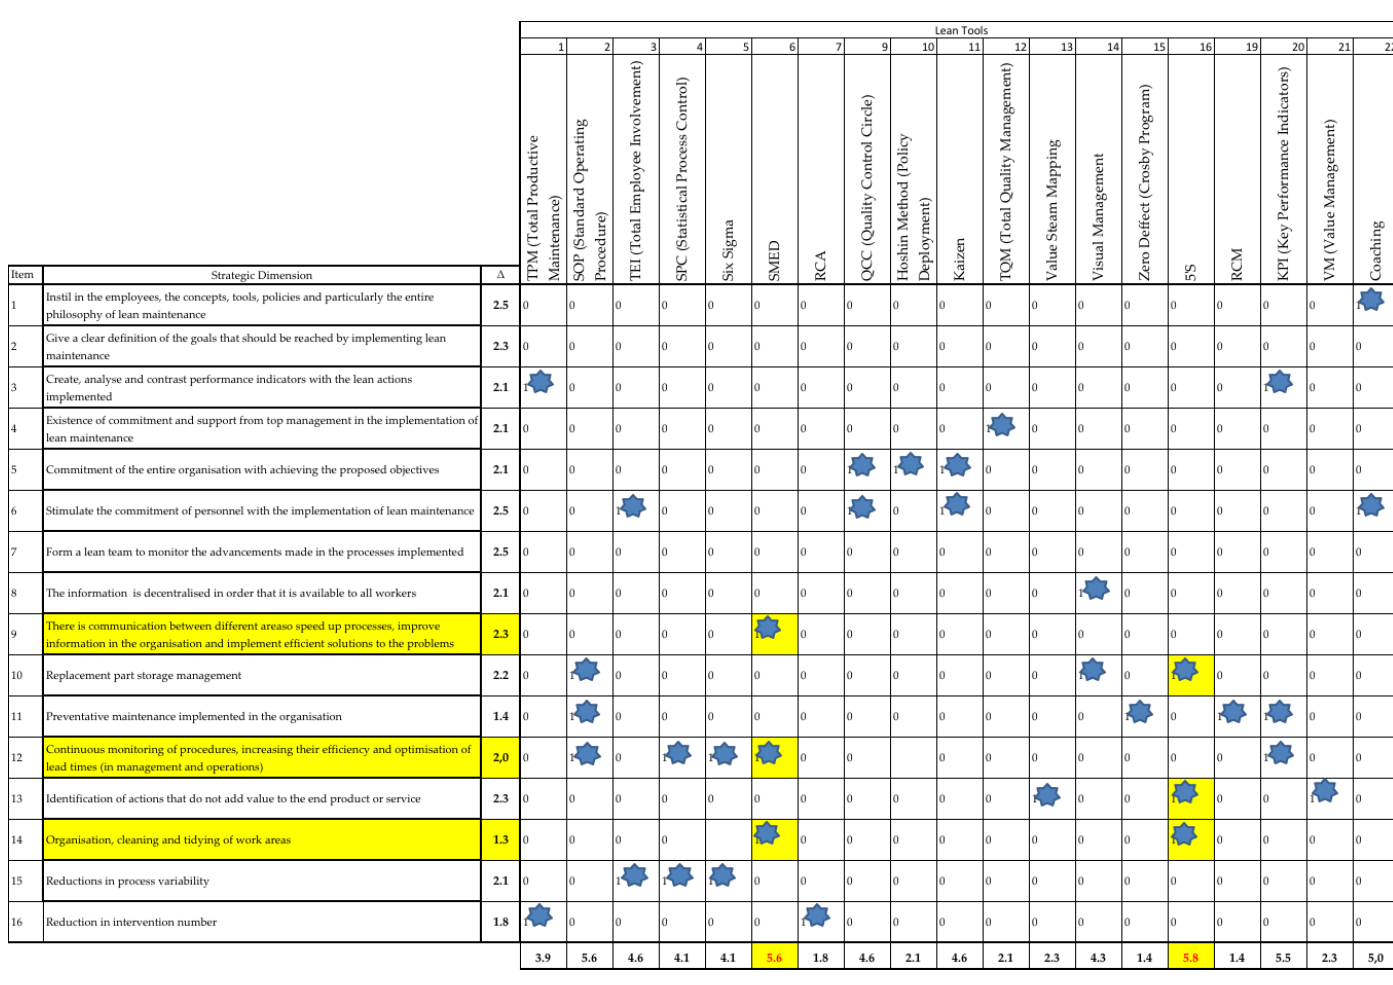
Figure 6. Lean tools prioritization mechanism using the decision table.